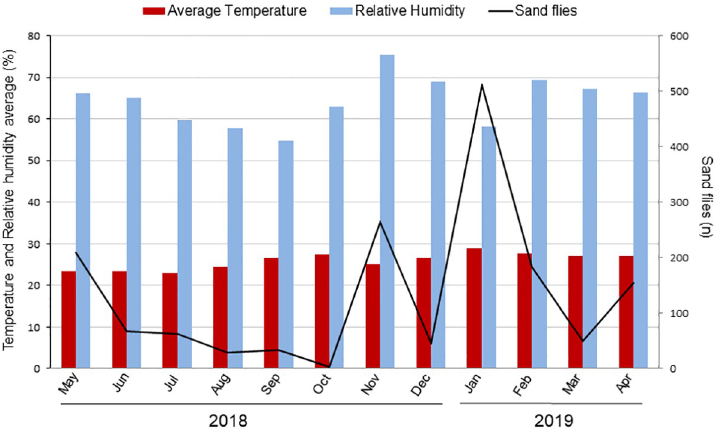
Fig 4. Average temperature, relative humidity and sand fly abundance during the sampling period in Lassance, Minas Gerais,